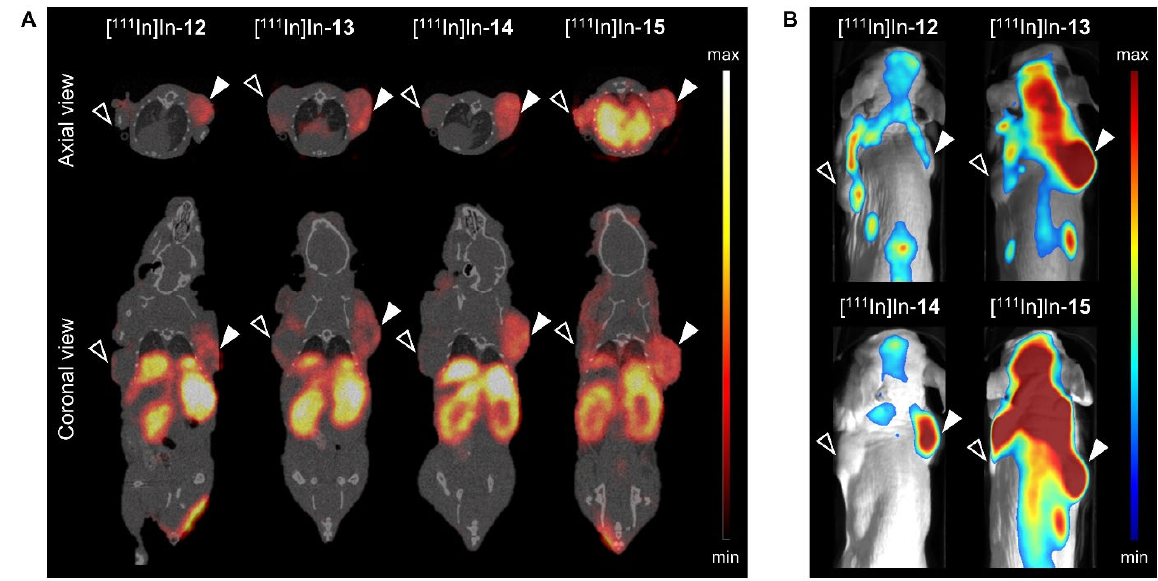
Figure 3 . In vivo SPECT/CT ( A ) and optical ( B ) images of GRPR-positive PC-3 ( ▲ ; right shoulder) and GRPR-negative NCI-H69 ( Δ ; left shoulder) tumor-bearing mice at 24 h post injection of [ 111 In]In- 12 - 15 (20 MBq/1 nmol). SPECT/CT images represent an overlay of a CT slice and the corresponding SPECT slice on which the tumor cross-sections are clearly visible. The arrow heads point to the location of the tumor.